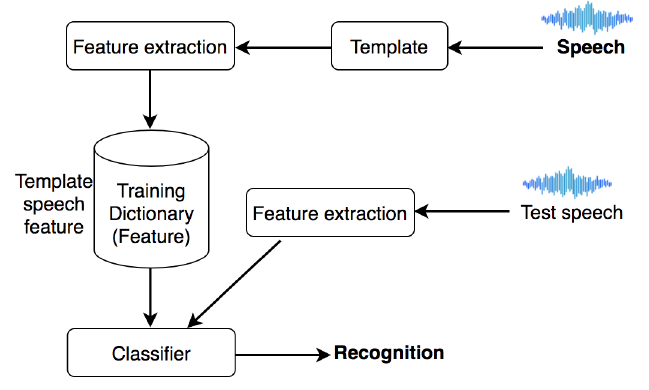
Figure 2. Flowchart of speech recognition